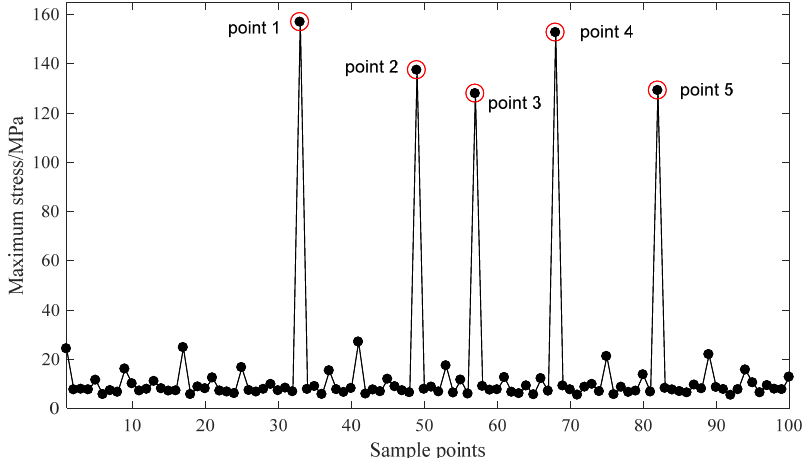
Figure 7. Bowl-shaped tiles’ maximum stress of 100 sample points.